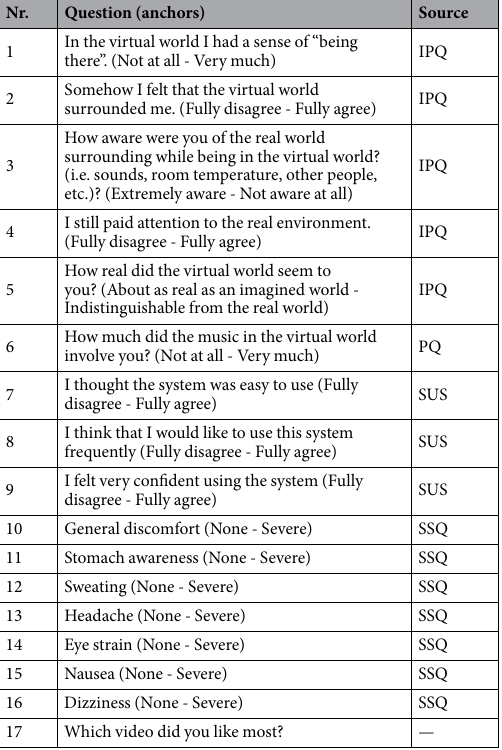
Table 3. Questionnaire to measure immersion, presence, usability and sickness in participants. (IPQ: Igroup Presence Questionnaire, PQ: Presence Questionnaire 60 , SUS: System Usability Scale, SSQ: Simulator Sickness